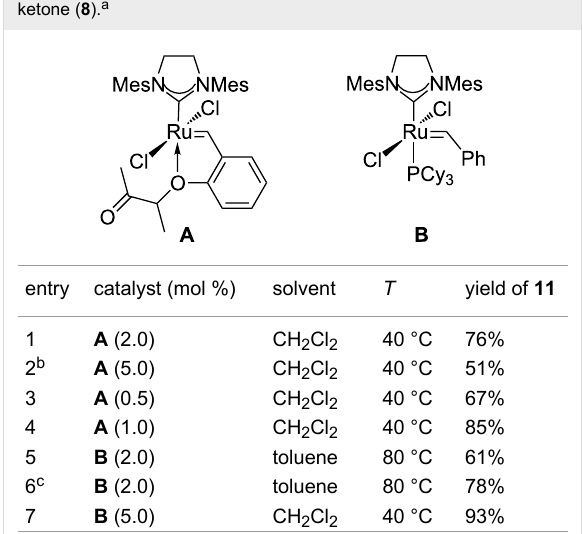
Table 1: Optimization of conditions for CM of 10 and methyl vinyl ketone ( 8 ). a